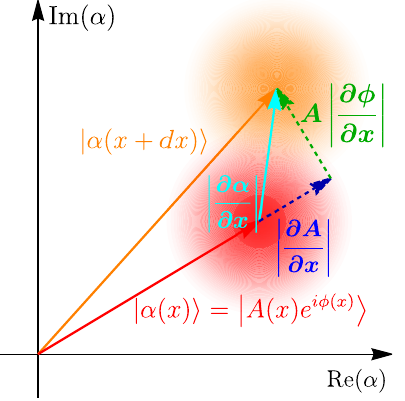
FIG. 3. Precision of estimation of an unknown parameter x by measurement of a coherent state of light | α (cid:4) . A change dx in some parameter x modifies the amplitude (blue) and phase (green) of | α( x ) (cid:4) . The optimum amount of information about dx can be extracted by measuring the state quadrature along the direction of change ∂α/∂ x of the coherent state, which in general is a combi- nation of phase and amplitude measurements. The shot noise of the coherent state of light (color-shaded area) limits the precision of the